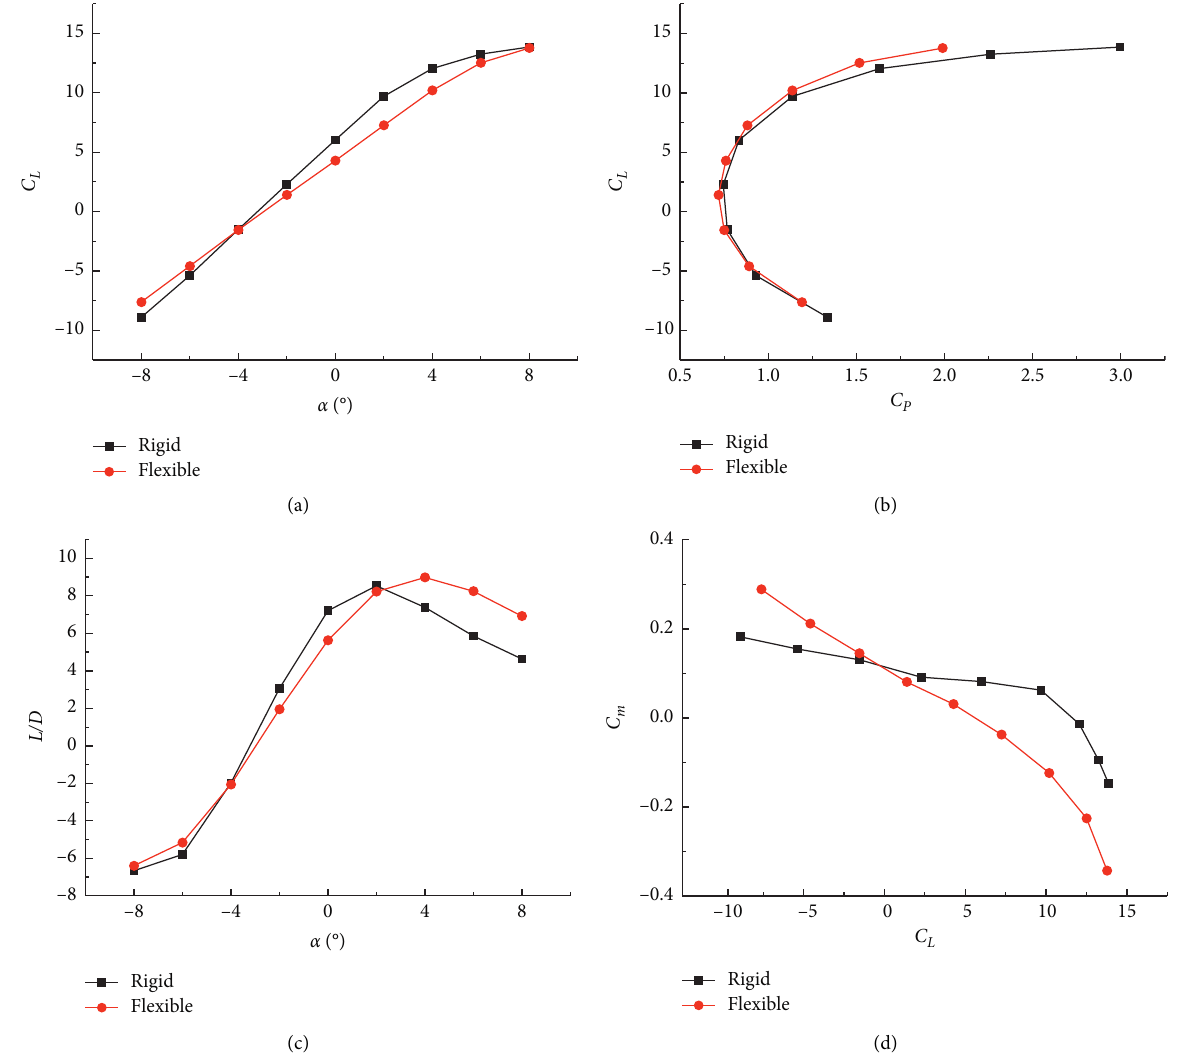
Figure 9: Effects of static aeroelasticity on bomb’s aerodynamic characteristics. (a) C